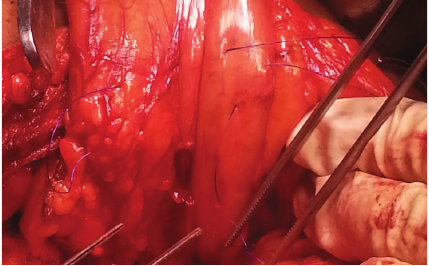
Figure 2: Purse string suture is made in the posterior gastric